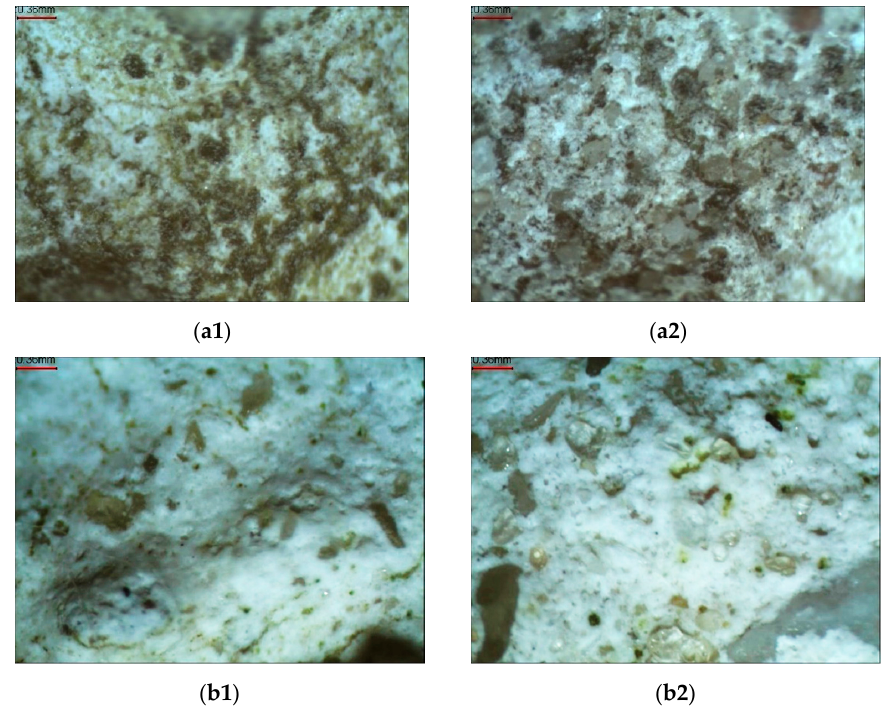
Figure 10. Photographs of the plaster surface with biofilm and after cleaning for the N and S orientation: ( a1 ) N-oriented sample with biofilm; ( b1 ) N-oriented sample after cleaning; ( a2 ) S-oriented sample with biofilm; and ( b2 ) S-oriented sample after cleaning.